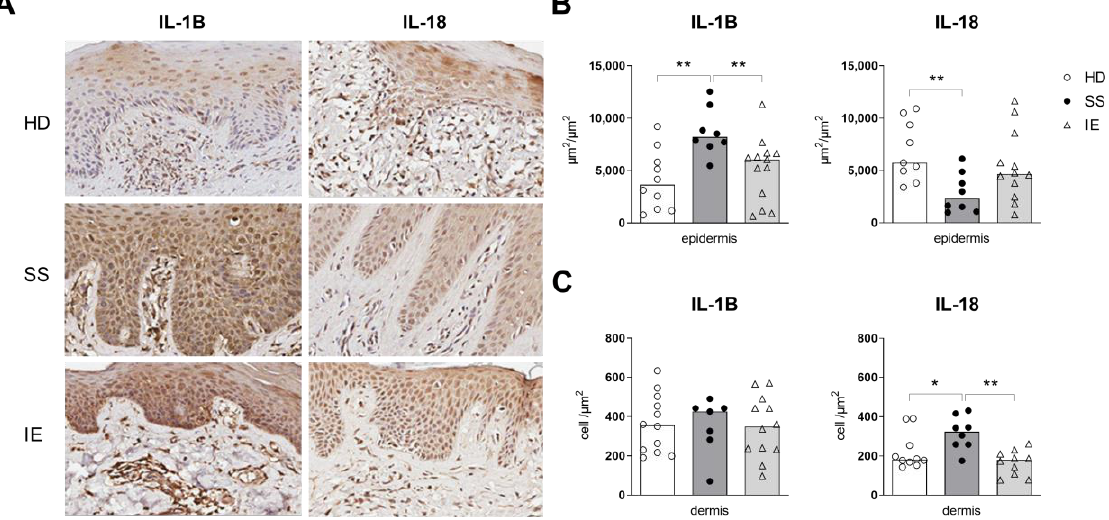
Figure 1. Increased protein levels of epidermal IL-1B and dermal IL-18 in skin of erythrodermic SS. The expression of IL-1B and IL-18 ( A ) were assessed in the skin biopsies of SS patients ( n = 7–8, closed circle), healthy donors (HDs, n = 9–12, open circle), and idiopathic erythroderma (IE, n = 9–13, open triangle) by immunohistochemistry. The analyses were performed on the epidermis ( B ) and dermis ( C ). The values are expressed as medians. * p ≤ 0.05 and ** p ≤ 0.01.